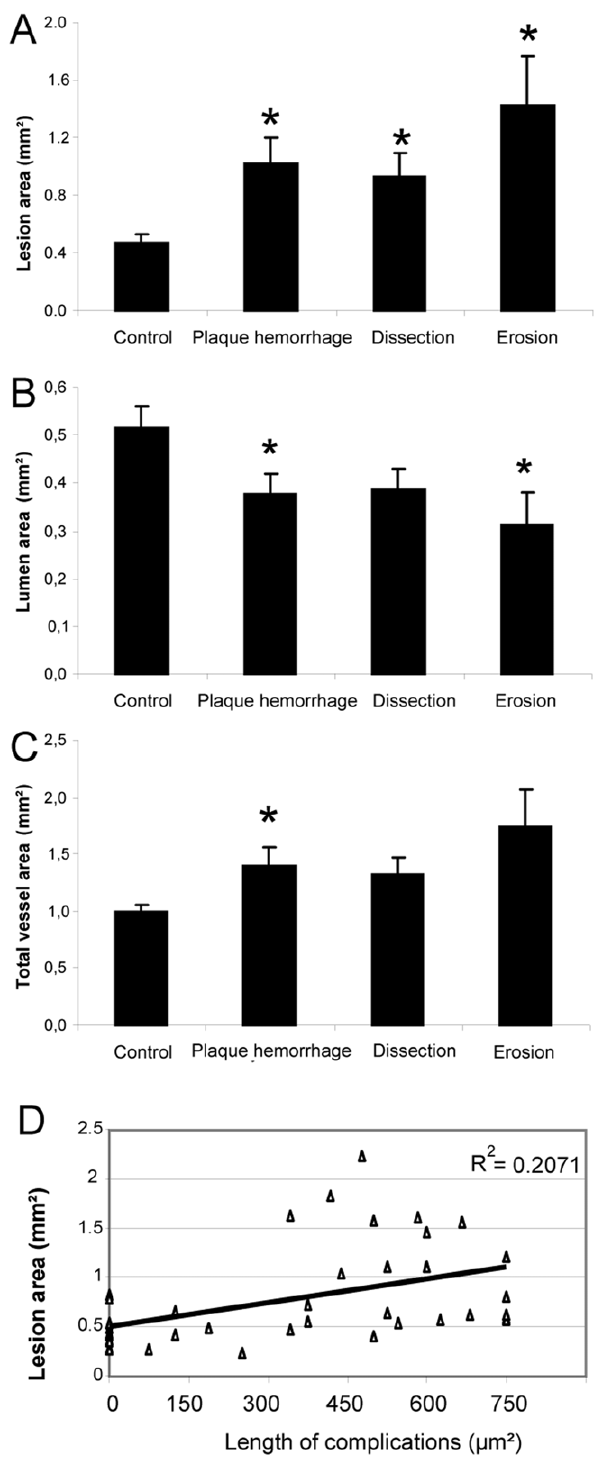
Figure 4. Quantification of vein grafts without complications (Control), and vein grafts with complications, namely plaque hemorrhage, dissections or erosions (n=10/group). A ; Vessel wall area measurements B ; Quantification of lumen area C ; Total vessel area (combined lumen and vessel wall area, as a measure for outward remodeling) D ; Correlation between the vessel wall area and the length of the plaque rupture complications.